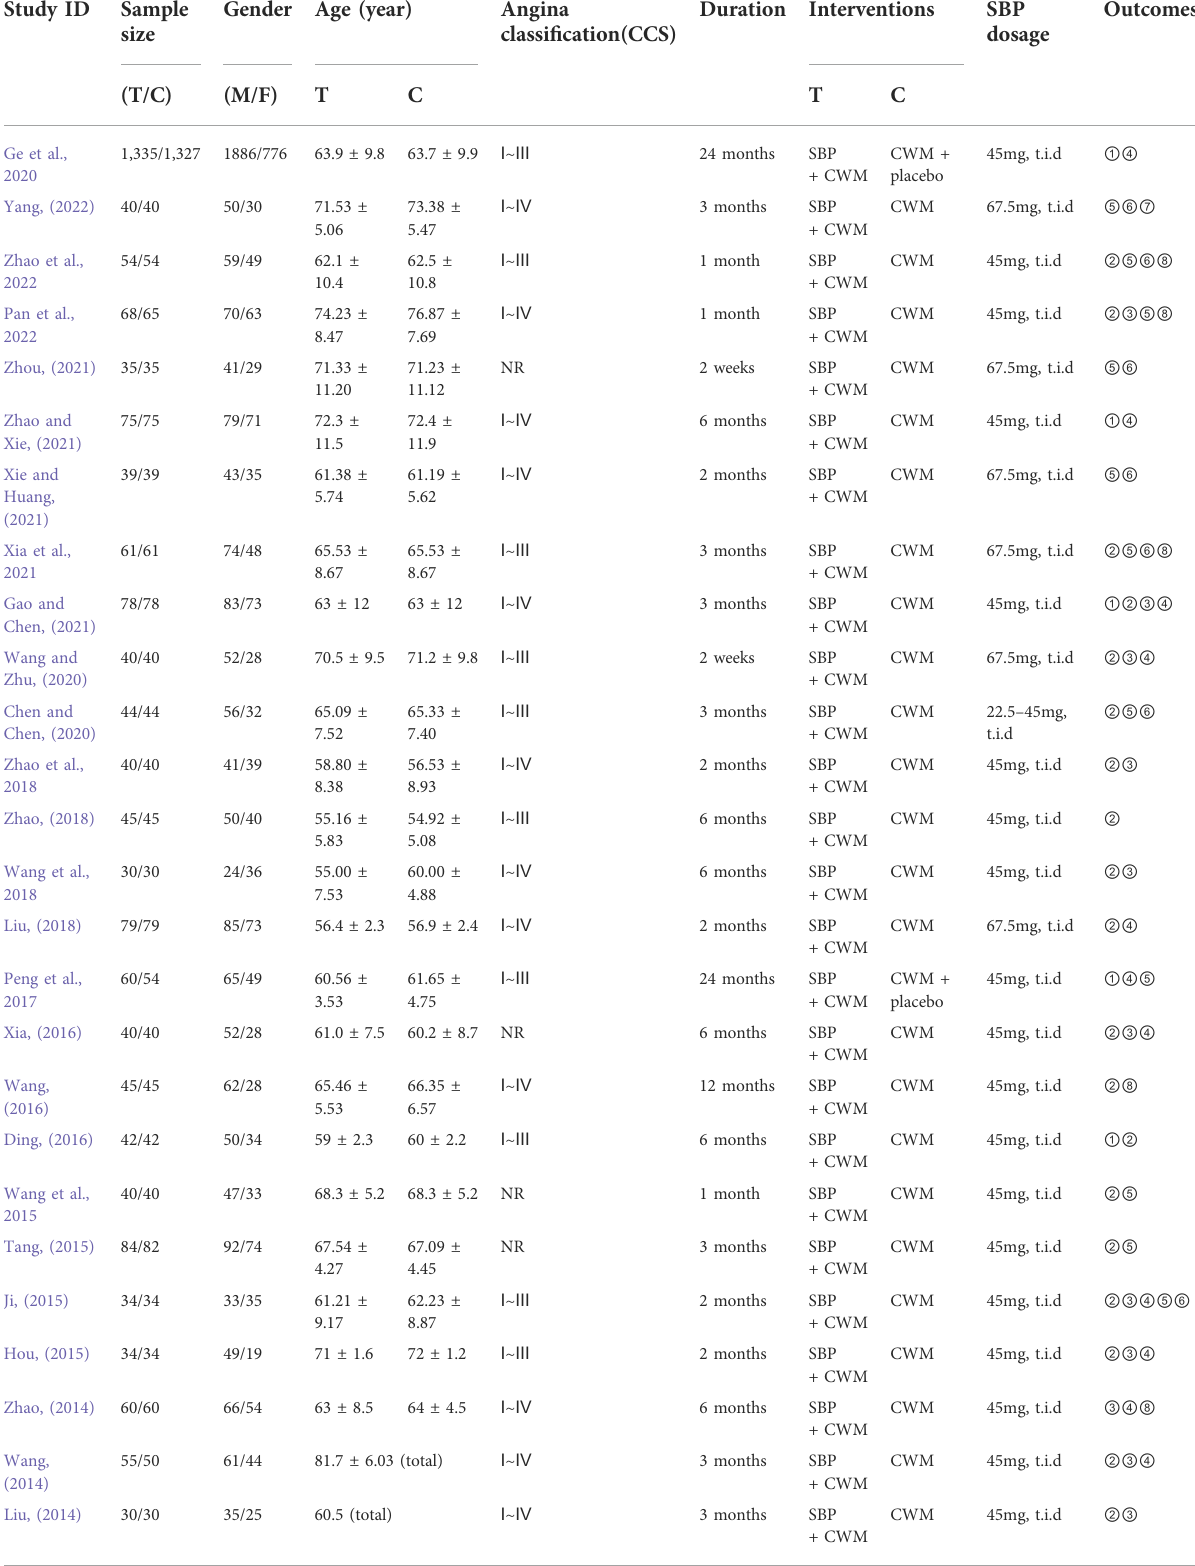
TABLE 1 Characteristics of the included